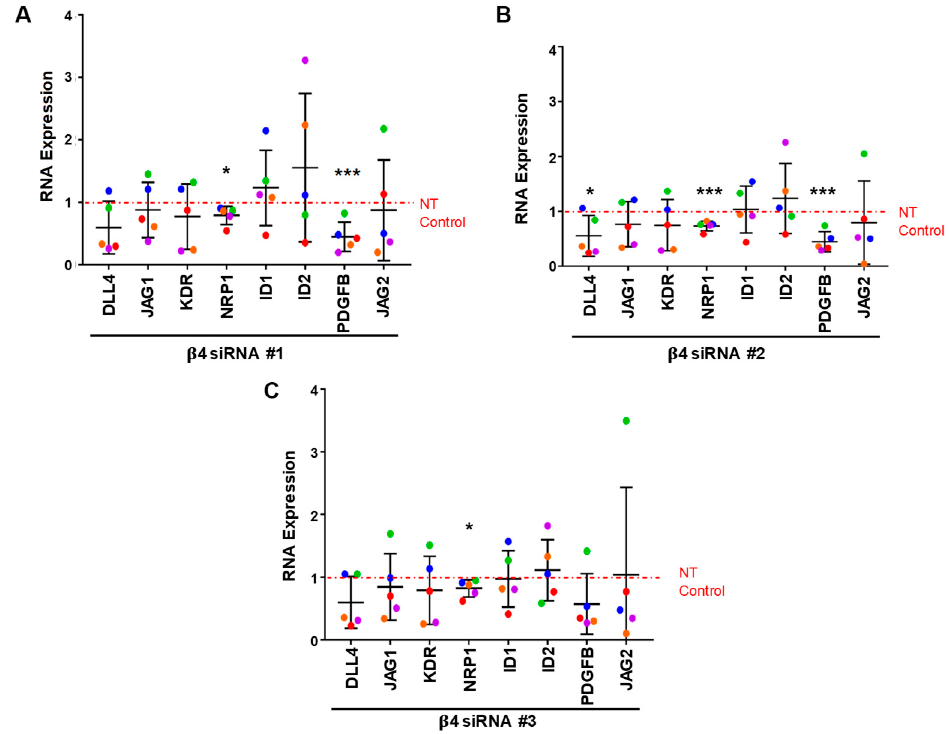
Figure 5. The expression of NRP1 and PDGFB are positively associated with integrin α 6 β 4 expression. Changes in RNA expression in 5-day bead-sprout assays of β 4-depleted endothelial cells and control cells were measured by qPCR. The efficiency of β 4 depletion using 3 siRNA targeting sequences was previously shown in Figure 4. Effects of β 4 knockdown with siRNA #1 ( A ), siRNA #2 ( B ), or siRNA# 3 ( C ) on the expression of genes associated with angiogenesis. Data were normalized to β -actin and then to non-targeting (NT) control. Plotted is the mean RNA expression ± s.d. n = 5 independent experiments. Mean expression of each gene was compared to non-targeting (NT) control. Data were analyzed using a Single-Sample t -test. Each independent experiment is represented by a different color. * p ≤ 0.05, *** p ≤ 0.001.